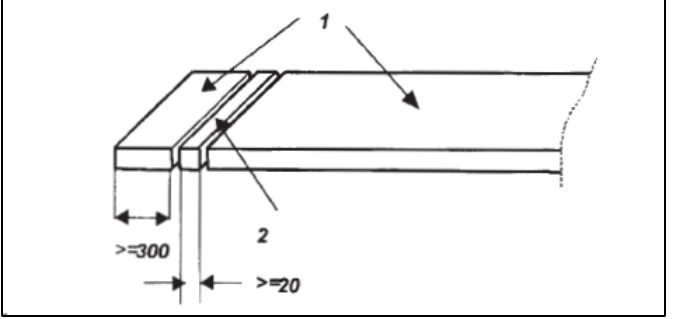
Figure 2. Pull-out Test Set Up.